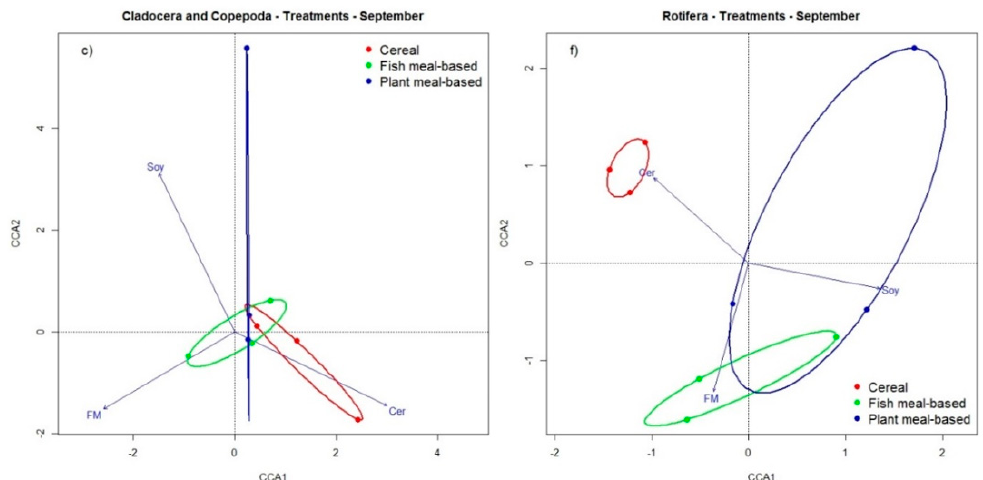
Figure 6. Canonical Correspondence Analysis (CCA) results of the community-scale effect of feed ingredient parameters on the distribution of rotifera and Crustacean (cladocera and copepoda) communities by months. Abbreviations of water chemistry parameters (a–c): TN—Total nitrogen;